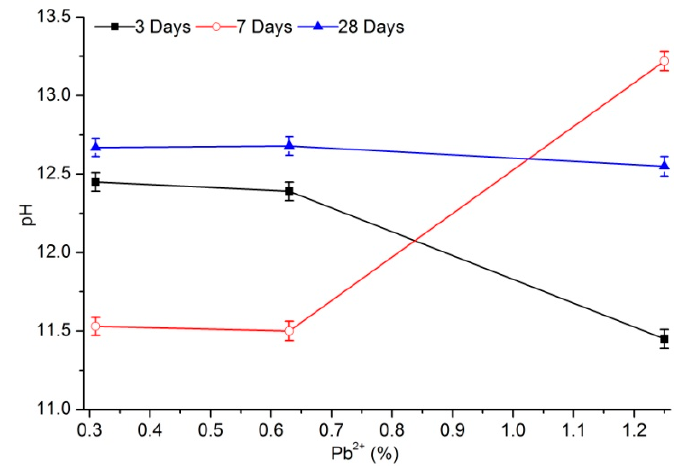
Figure 3. pH of percolate from samples stabilized with PC.